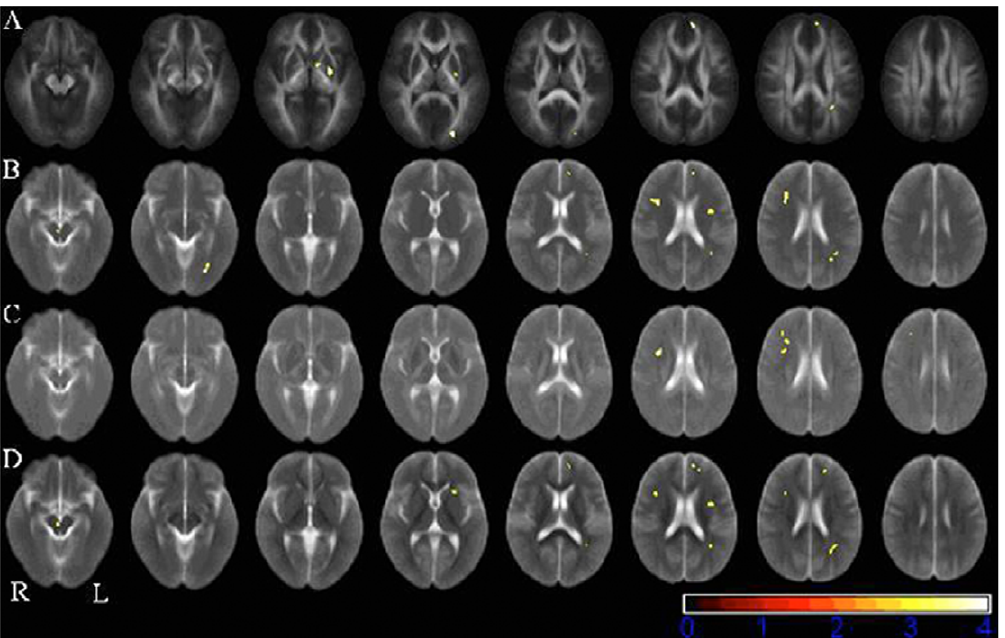
Figure 1. Voxel-based analysis between 27 patients with obsessive-compulsive disorder and 23 healthy controls before medication. The results were overlaid on mean images of corresponding diffusion tensor imaging (DTI) parameters. A. Fractional Anisotropy (FA) decrease; B. Mean Diffusion (MD) increase; C. Axial diffusion (AD) increase; D. Radial diffusion (RD) increase; p , 0.001 uncorrected and cluster size . 10 voxels. No increased FA and decreased diffusion coefficients (AD, RD and MD) were found.